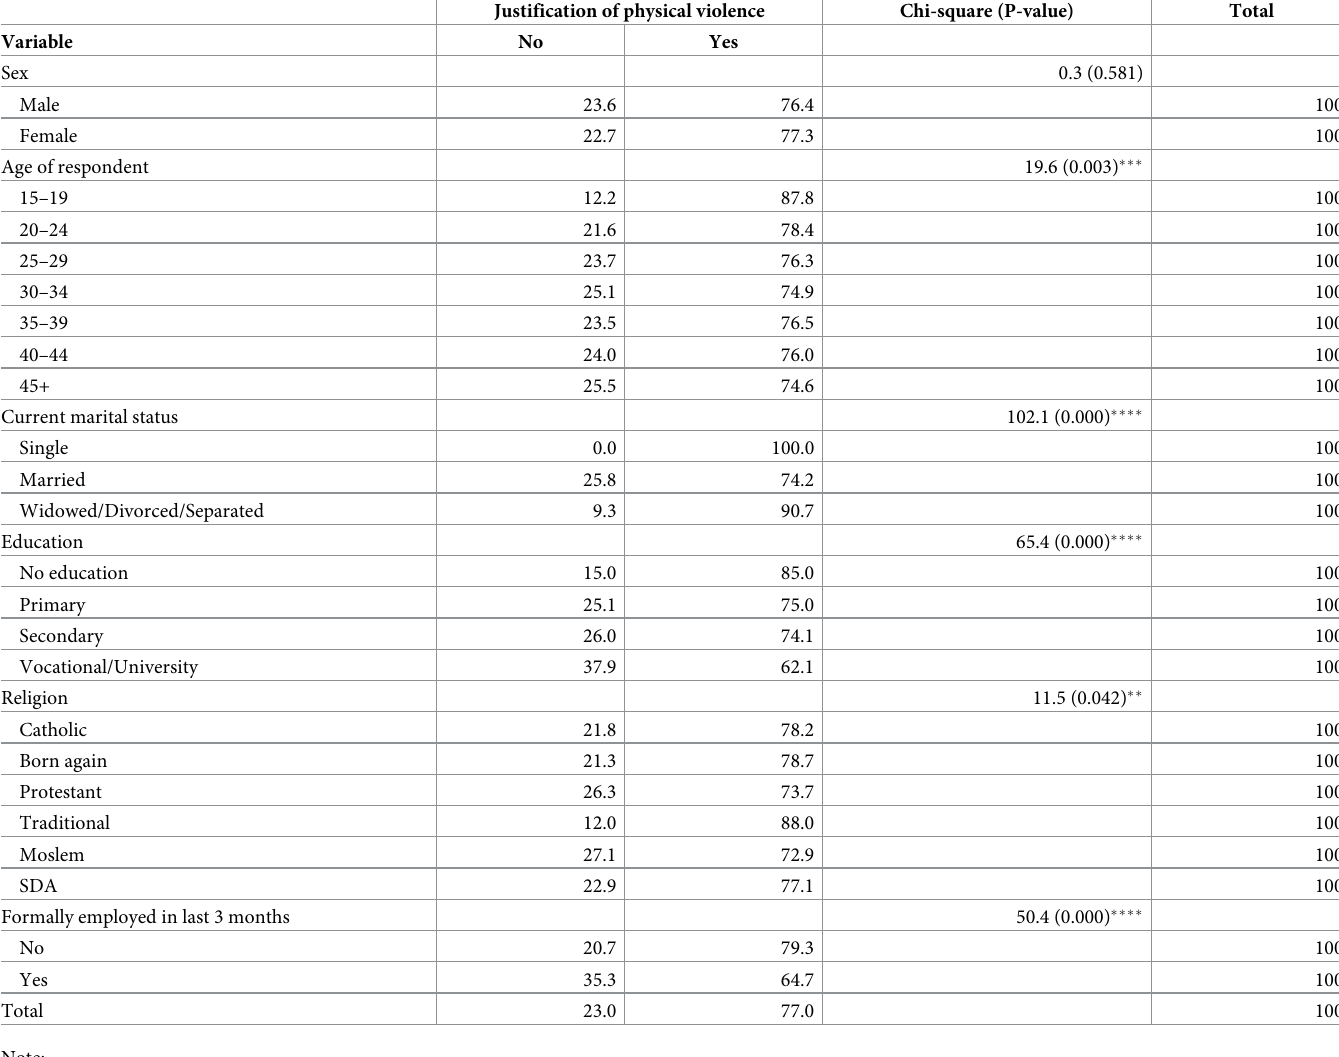
Table 3. Relationship between socio-economic and demographic factors and justification of physical violence against